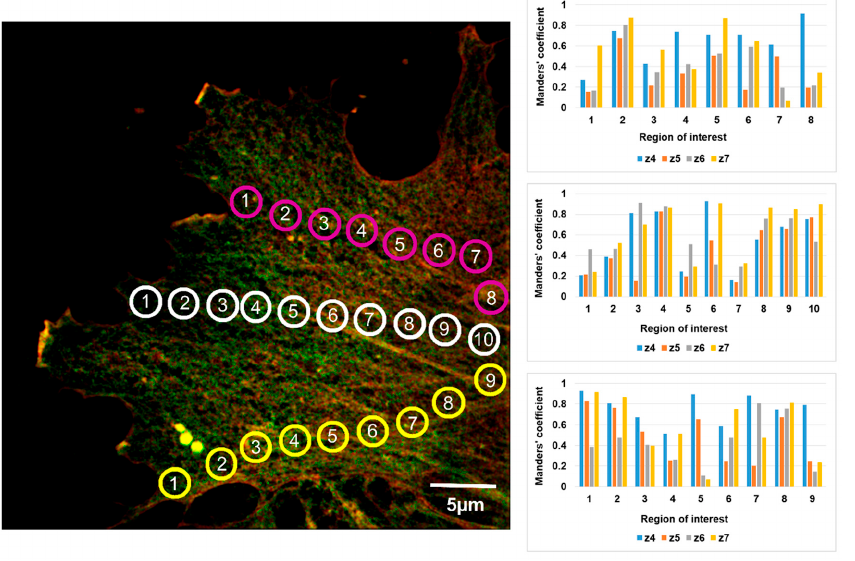
Figure 4. Colocalization of β - and γ -actin in different regions of the same HPAEC. Three measure- ment series were performed in ROI defined by circles (marked in magenta, white and yellow) and positioned in a line connecting the edge and center of the cell. Histograms present the respective tM1 Manders’ coefficient values. For each ROI in a series, the coefficient values are provided for four consecutive optical sections (two middlemost ones and two adjacent ones located above and below). In most cases, the tM1 coefficient values were noticeably below 1, indicating partial colocalization of β - and γ -actin. Minimal coefficient values were observed at the cell edge and adjacent to the cell nucleus (Series 1); at half way along the ROI-positioned line and at the cell edge (Series 2), or adjacent to the cell nucleus (Series